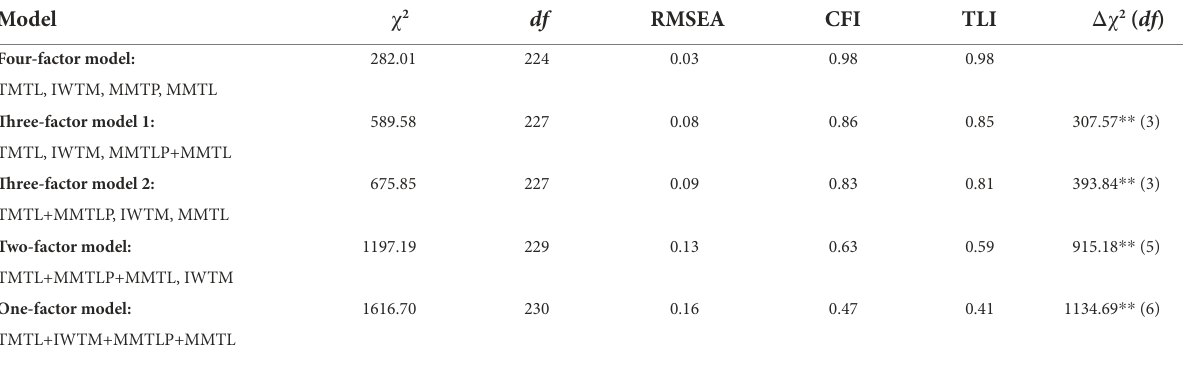
TABLE 2 Results of confirmatory factor